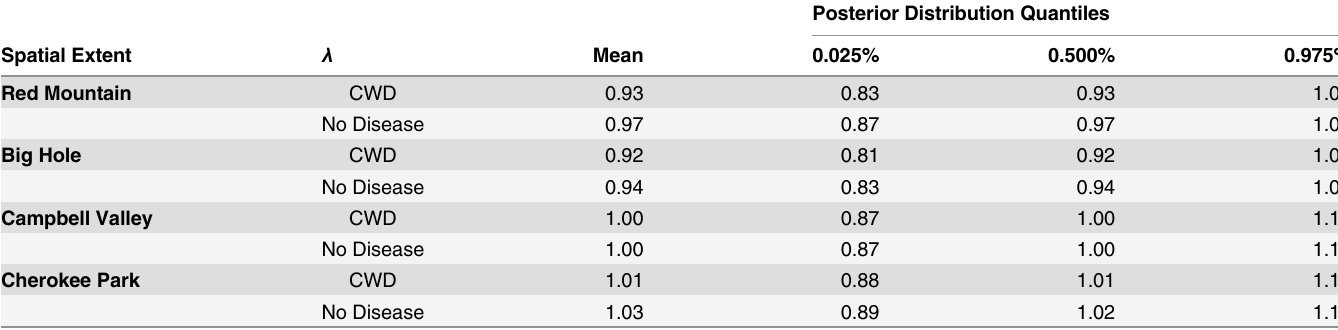
Table 3. Estimates of subpopulation growth rates with and without